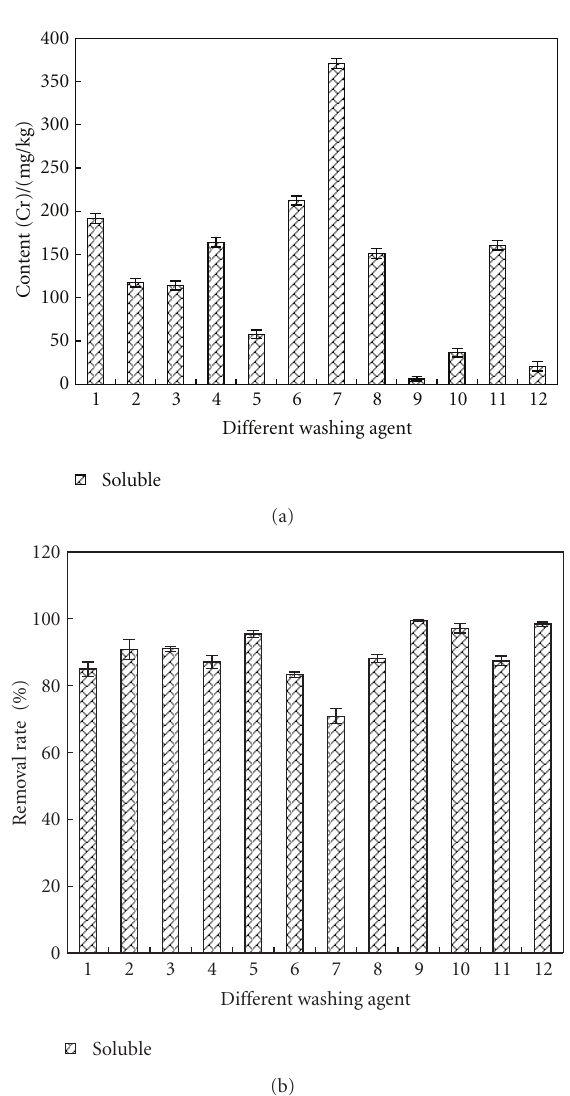
Figure 7: Removal e ff ect of soluble Cr by di ff erent washing